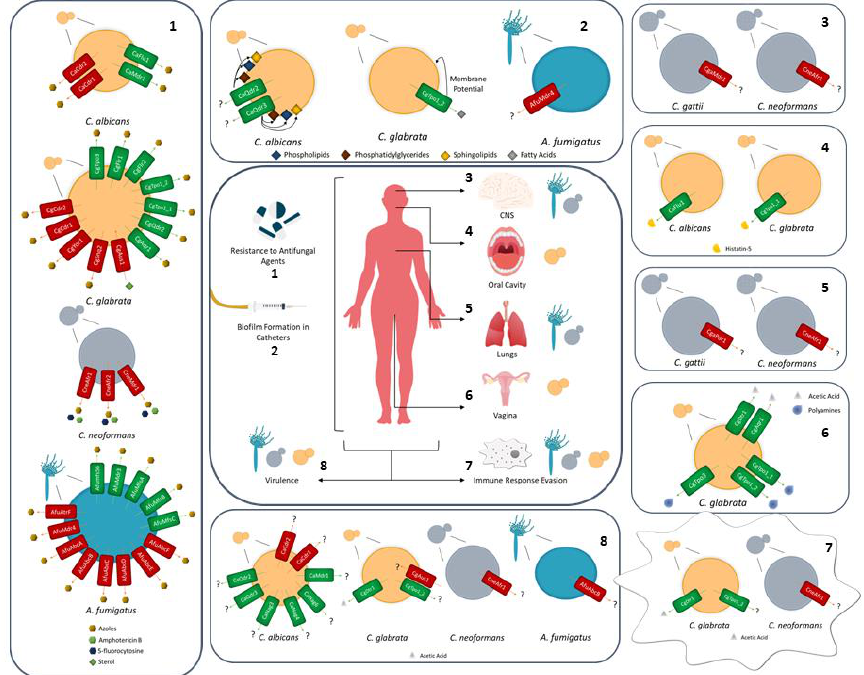
Figure 1. The role of multidrug resistance (MDR) transporters in the survival of Candida , Cryptococcus , and Aspergillus species upon infection in the human host. (1) MDR transporters involved in multiple azole resistance; (2) MDR transporters necessary for biofilm formation; (3) MDR transporters involved in Cryptococcus species virulence in the central nervous system (CNS); (4) MDR transporters involved in the efflux of histatin-5 in the oral cavity; (5) MDR transporters involved in Cryptococcus species virulence in the lungs; (6) Candida glabrata MDR transporters involved in polyamine or acetic acid export for the survival in the vaginal tract; (7) MDR transporters involved in the fight against the immune response of the host; and (8) MDR transporters known to be essential for normal virulence of fungal pathogens. The central picture summarizes the niches of infection in which the referred fungal pathogens are found. ATP-binding cassette (ABC) transporters are highlighted in red and major facilitator superfamilies (MFS) transporters are highlighted in green.